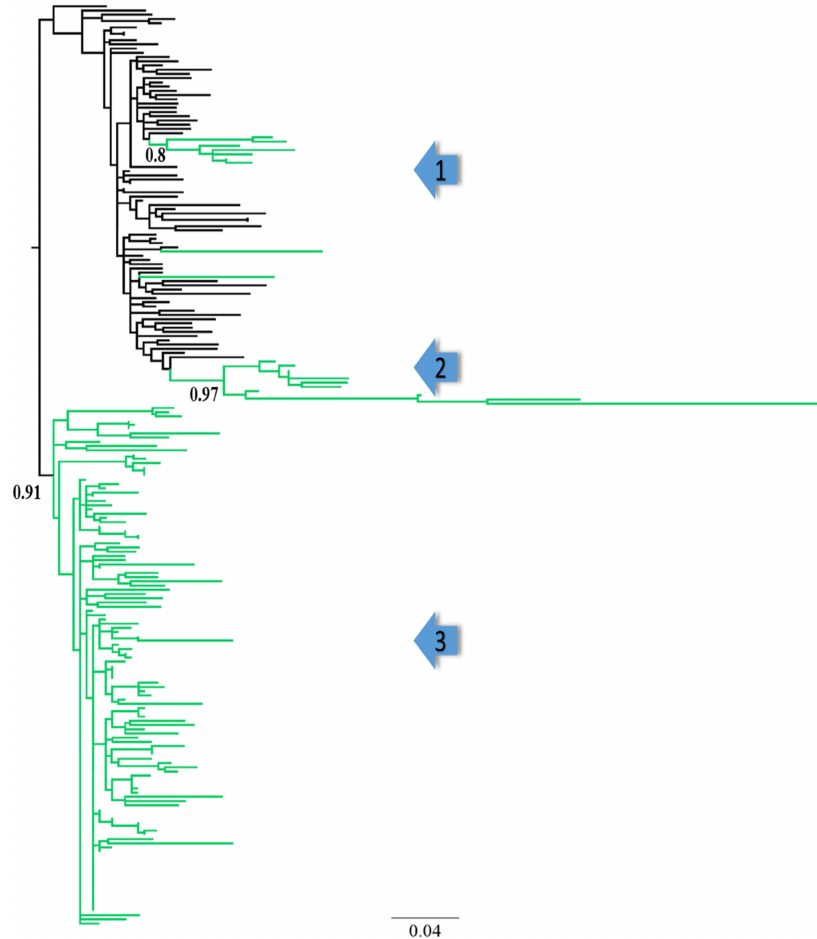
Figure 1. Phylogenetic clusters of HIV-1 sub-subtype A1 in Pakistan. Tips in green and black represent, respectively, Pakistani and Kenyan (reference) HIV-1 sub-subtype A1 sequences. Arrows indicate clusters 1, 2, and 3 in the phylogenetic tree, while the aLRT-SH support values of the three clusters are also